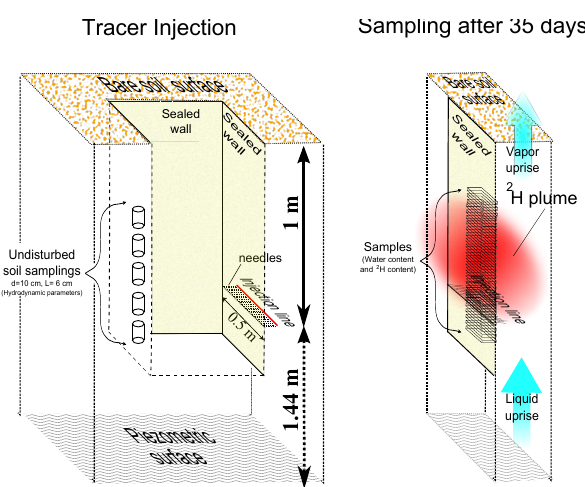
Fig. 1. Block diagram presenting injection pit and recovering sam- pling procedures of D tracer in the soil